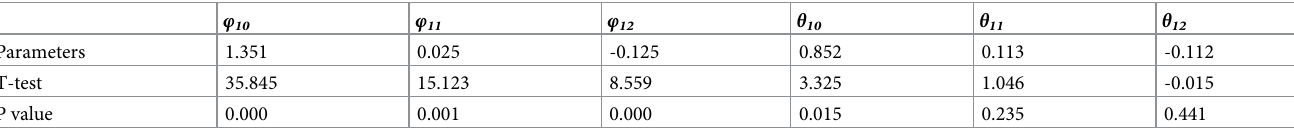
Table 9. Parameter estimation and test results for the SD-STARMA